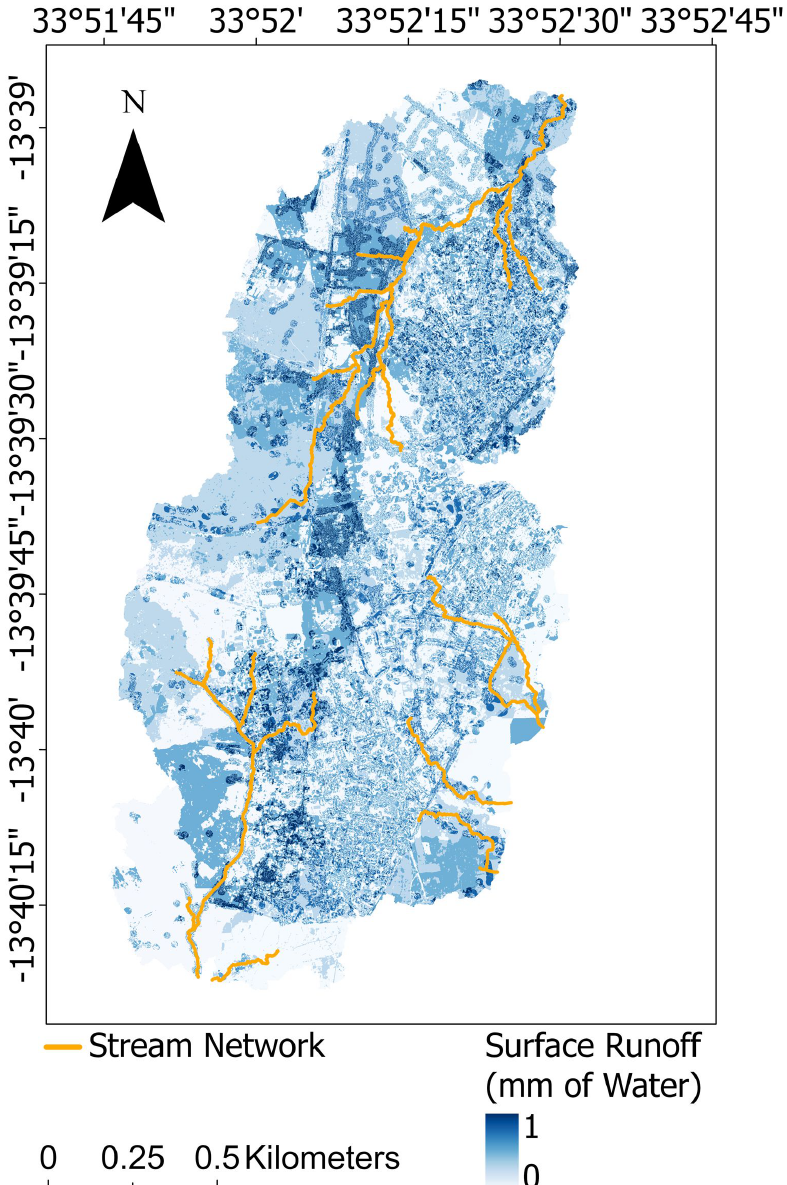
Figure 17. Comprehensive flood model of Dzaleka Refugee Camp, created by combining the normal- ized 10% exceedance probability of surface runoff and